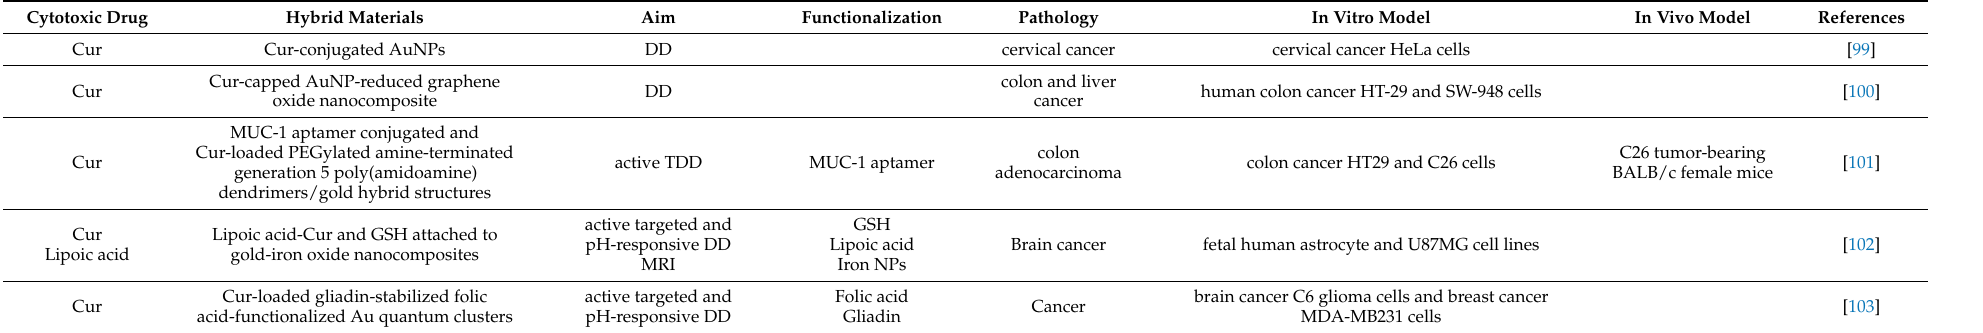
Table 4. Hybrid systems based on AuNPs and Cur and projected as potential candidates for the treatment of human